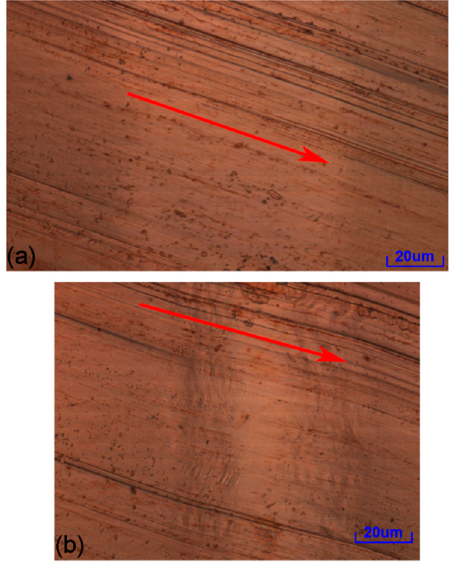
Figure 24. Local magnified surface topography of the rear side surface of the embossed microchannel (which is face to face with the liquid): ( a ) Surface image at the bottom region and ( b ) surface topography at the bar region. The arrows represent the rolling direction of the copper foil.